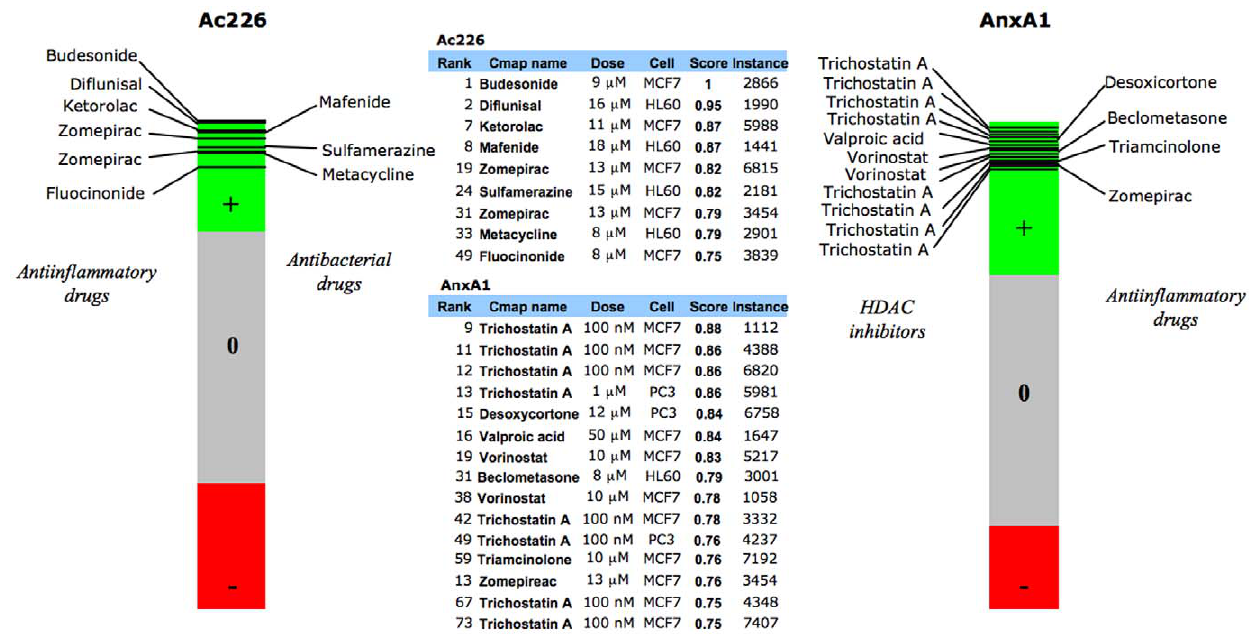
Figure 6. Connectivity Map results. Connectivity Map analysis of differentially expressed genes by 10 uM Ac2-26 peptide (103 genes) - left - and 0.5 uM AnxA1 (118 genes) - right -, in HEK293 cells transfected with the receptor ALX. Bar-views are constructed from more than 7,000 horizontal lines, each representing an individual treatment instance, ordered by their corresponding connectivity scores ( + 1, top; -1, bottom). Drugs with positive score are represented in green, while those with negative connectivity score are displayed in red. Only compounds with a positive score $ 0.75 are reported. A selection of these compounds is summarized in the table (middle).